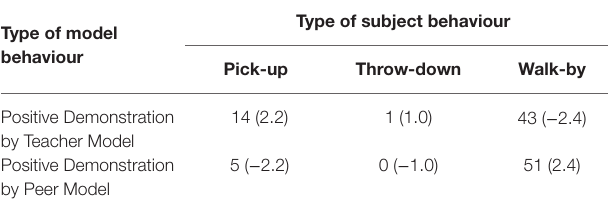
TABLE 2 | Crosstabulation of model’s behaviour type and subject’s behaviour type.